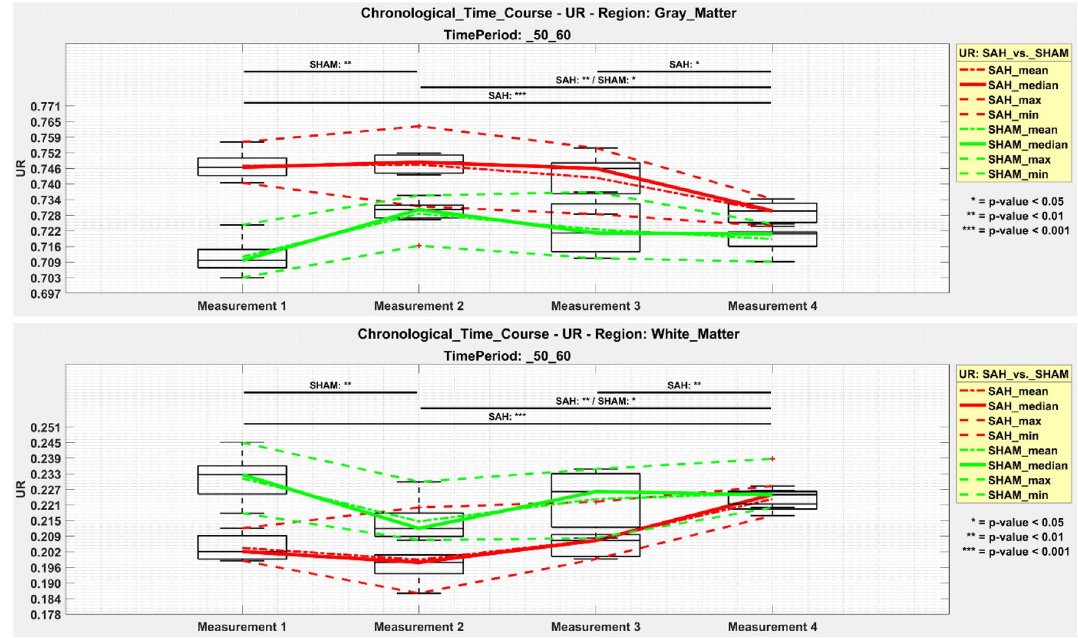
Figure 7. Chronological time course of [ 18 F]FDG uptake in SAH animals (red lines) and sham operated controls (green lines) over course of disease/observation period for gray (top) and white matter (bottom). Measurement 1 = 3 h following SAH/sham operation; Measurement 2 = 24 h respectively day 1 following SAH/ sham operation; Measurement 3 = day 4 following SAH/sham operation; Measurement 4 = day 7 following SAH/ sham operation. UR = uptake ratio. p ≤ 0.05 *; p ≤ 0.01 **; p ≤ 0.001